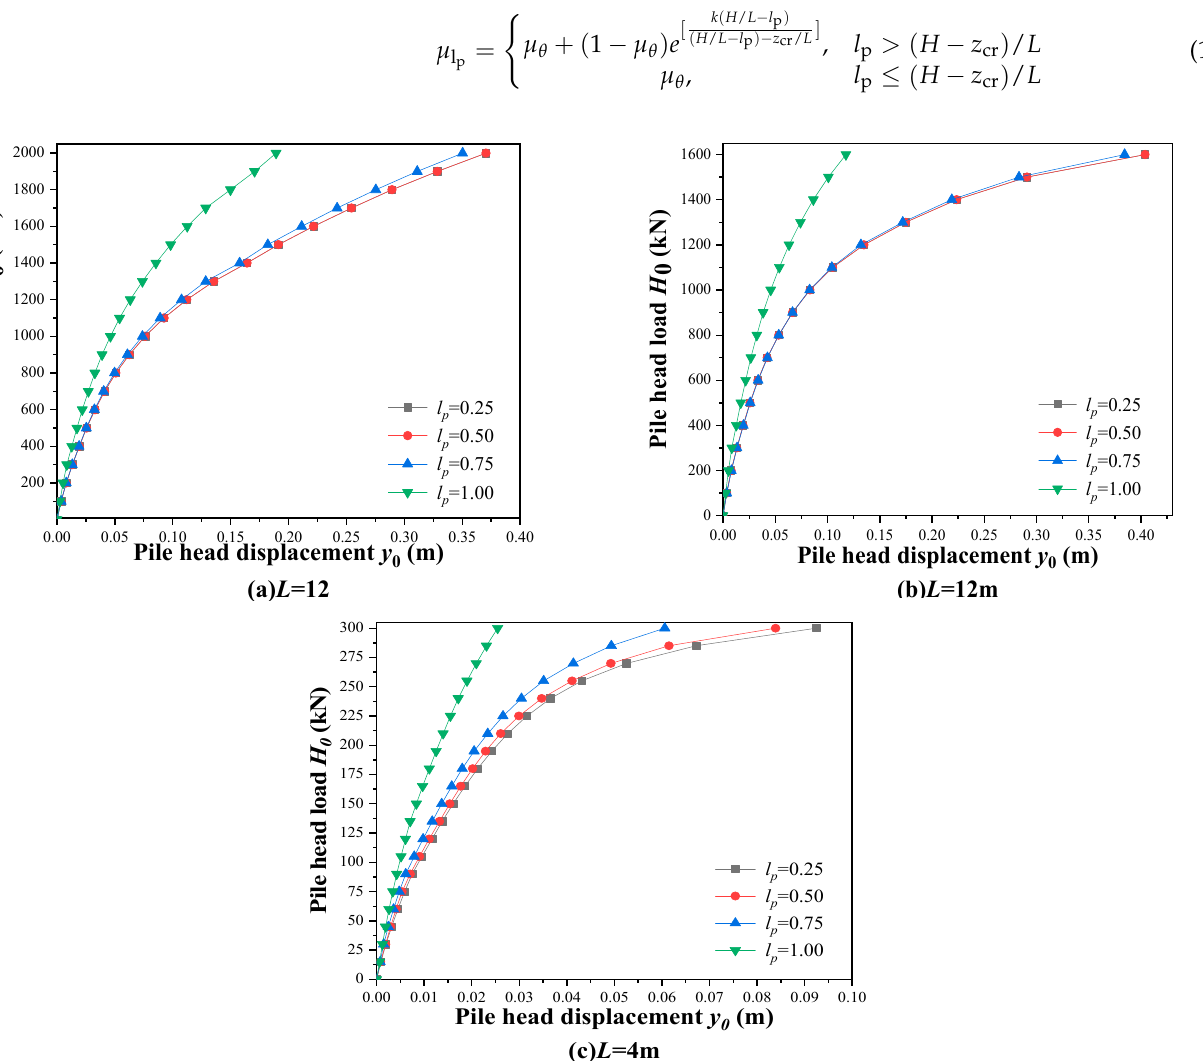
Figure 18. Effect of pile location on slope ( l p ) on pile head displacement from the data of FEA, for slope angle 𝜃 = 45° . Piles of ( a ) 20 m, ( b ) 12 m, and ( c ) 4 m lengths.